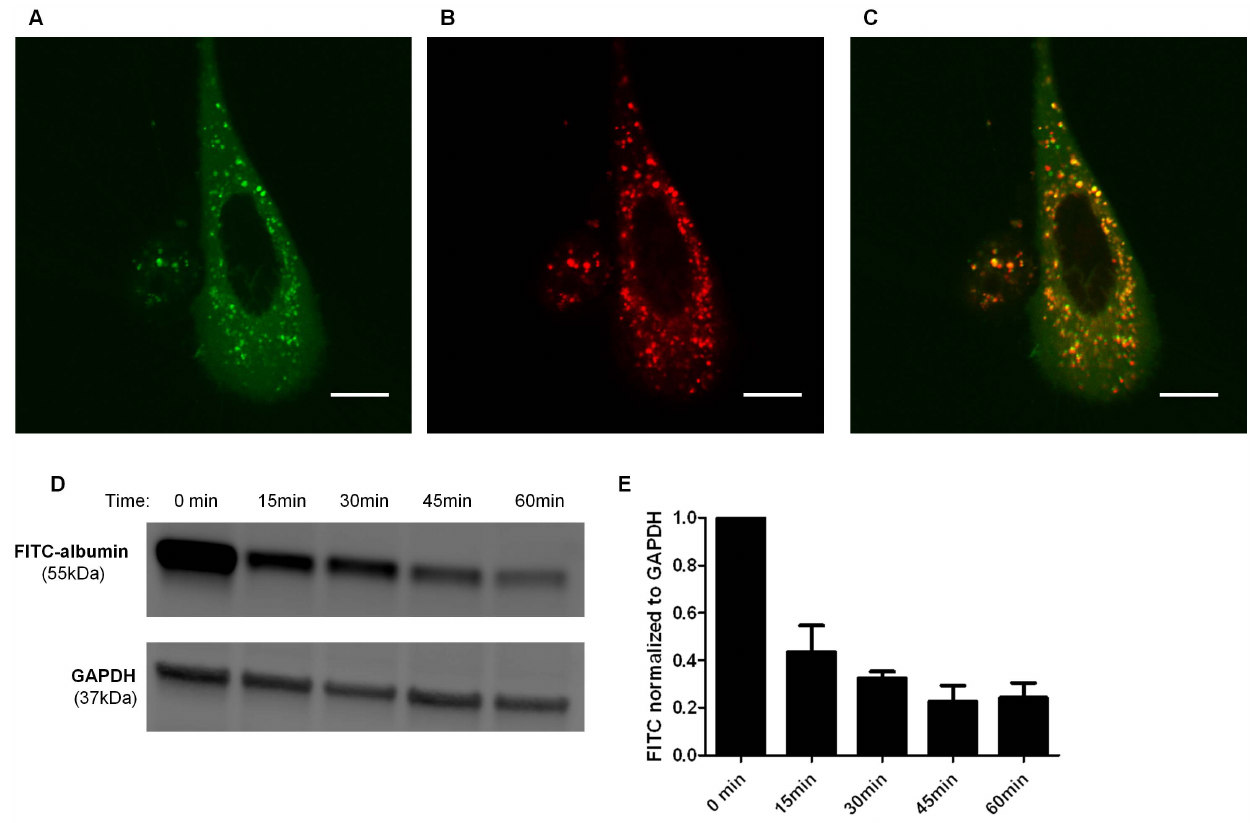
Figure 1. Endocytosed albumin co-localized with lysosomes and was degraded in podocytes. Confocal microscopy image demonstrating co-localization of albumin and lysosomes in a podocyte treated with 1.5 mg/mL FITC-albumin and Cathepsin B Magic Red for 1 hour. FITC- albumin was excited with a 488 nm laser and Magic Red with a 633 nm laser. FITC-Albumin is labeled green ( A ) and Magic Red, which selectively localizes in lysosomes, is labeled red ( B ). Yellow fluorescence represents albumin and Magic Red co-localization ( C ). Scale bar is 20 m m. D ) Representative Western blot demonstrating the time course of albumin degradation. Podocytes were treated with 1.5 mg/mL FITC-albumin for 1 h then washed. Cells were harvested at time zero, 15, 30, 45, and 60 min. Albumin abundance in cell lysates was quantified by Western blot analysis using an antibody to FITC. E ) Densitometry demonstrating an exponential decrease in abundance of FITC-albumin over 60 minutes normalized to GAPDH and abundance at time zero